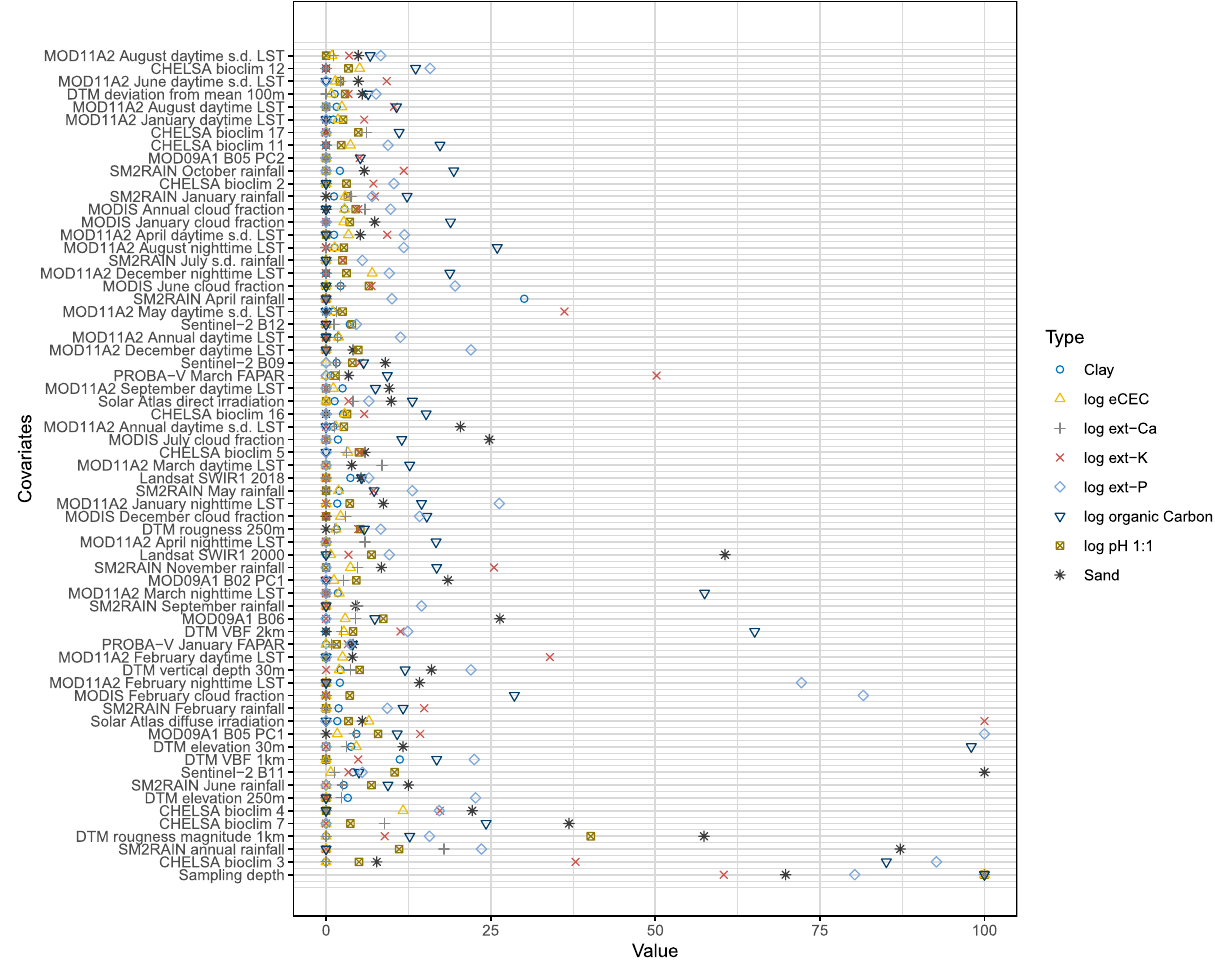
Figure 2. Relative covariate importance for selected target soil variables ordered based on mean importance of all 250 m and 30 m resolution covariates. In this instance, the covariate “sampling depth” is the overall most important covariate, while Sentinel-2 B11 and Landsat SWIR images are revealed as the highest ranked covariates at 30 m resolution (see further Table 1 and Supplementary